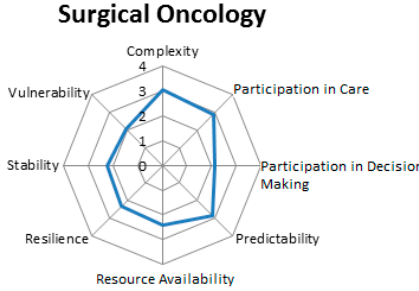
Figure 2. Spider Chart of Mean Synergy Scores for Patients on the HHSC Surgical Oncology Unit.